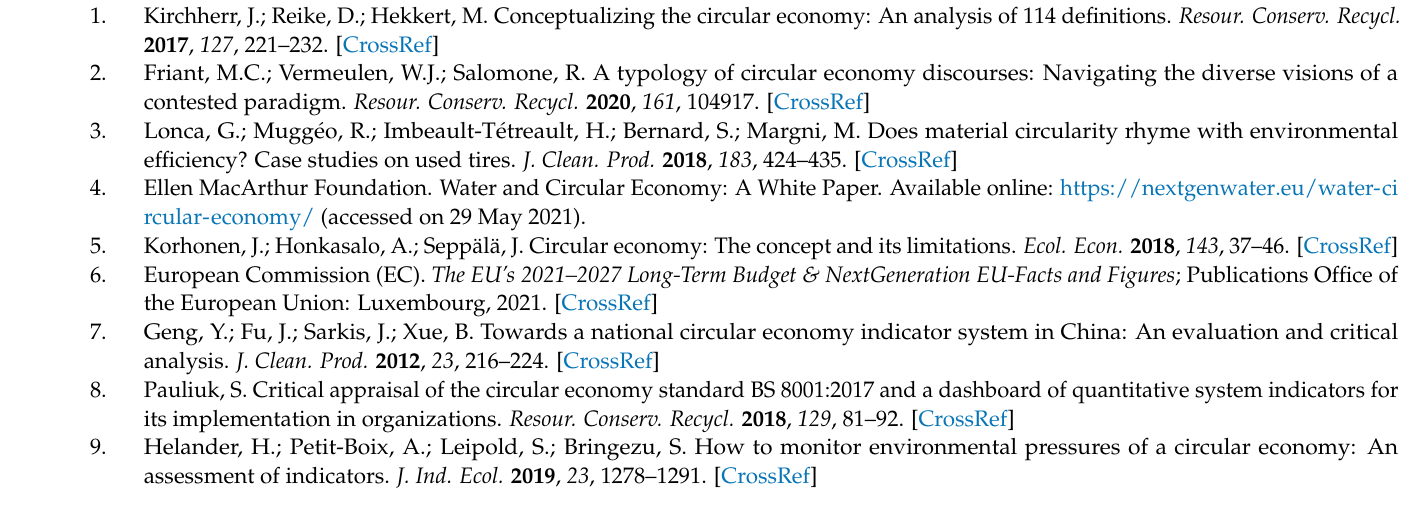
per sector, Figure S3: Interest in CE principles per sector, Figure S4: Interest in any other aspects for CE assessment, Table S1: List of CPIs to rate, Table S2: Number of responses per country, Table S3: Table S6: Second iteration, Table S7: Third iteration, Table S8: Fourth iteration, Table S9: Fifth iteration, Table S10: Sixth